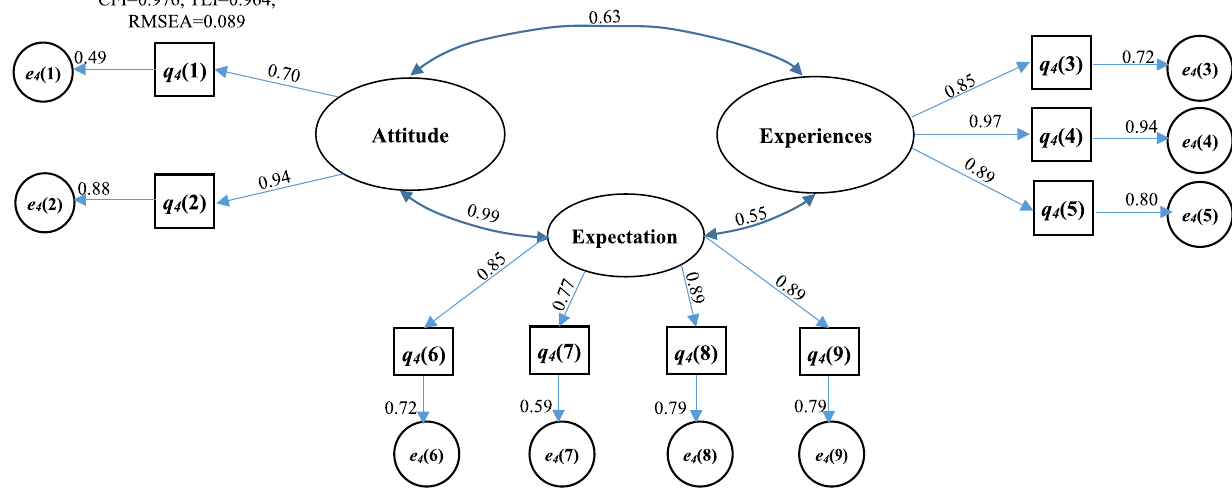
Fig. 5 Structural equation model describing the attitude, experience and expectation of undergraduate student for GTA’s